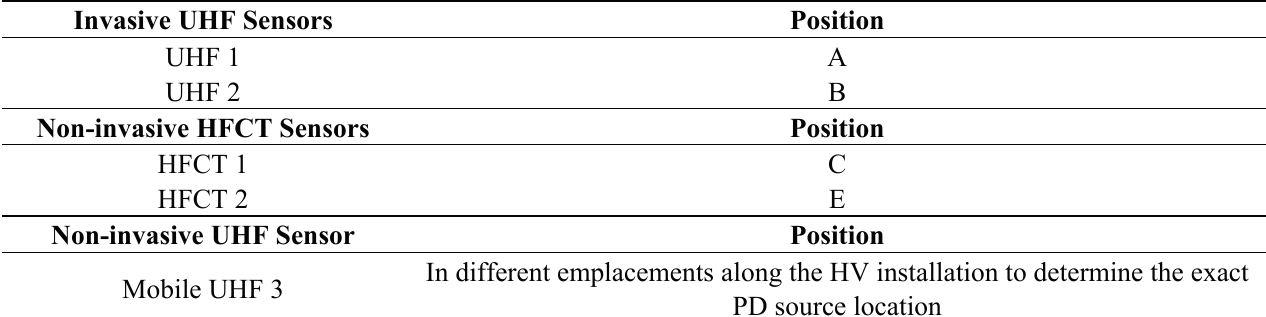
Table 2. Type of sensors and location in the test setup.